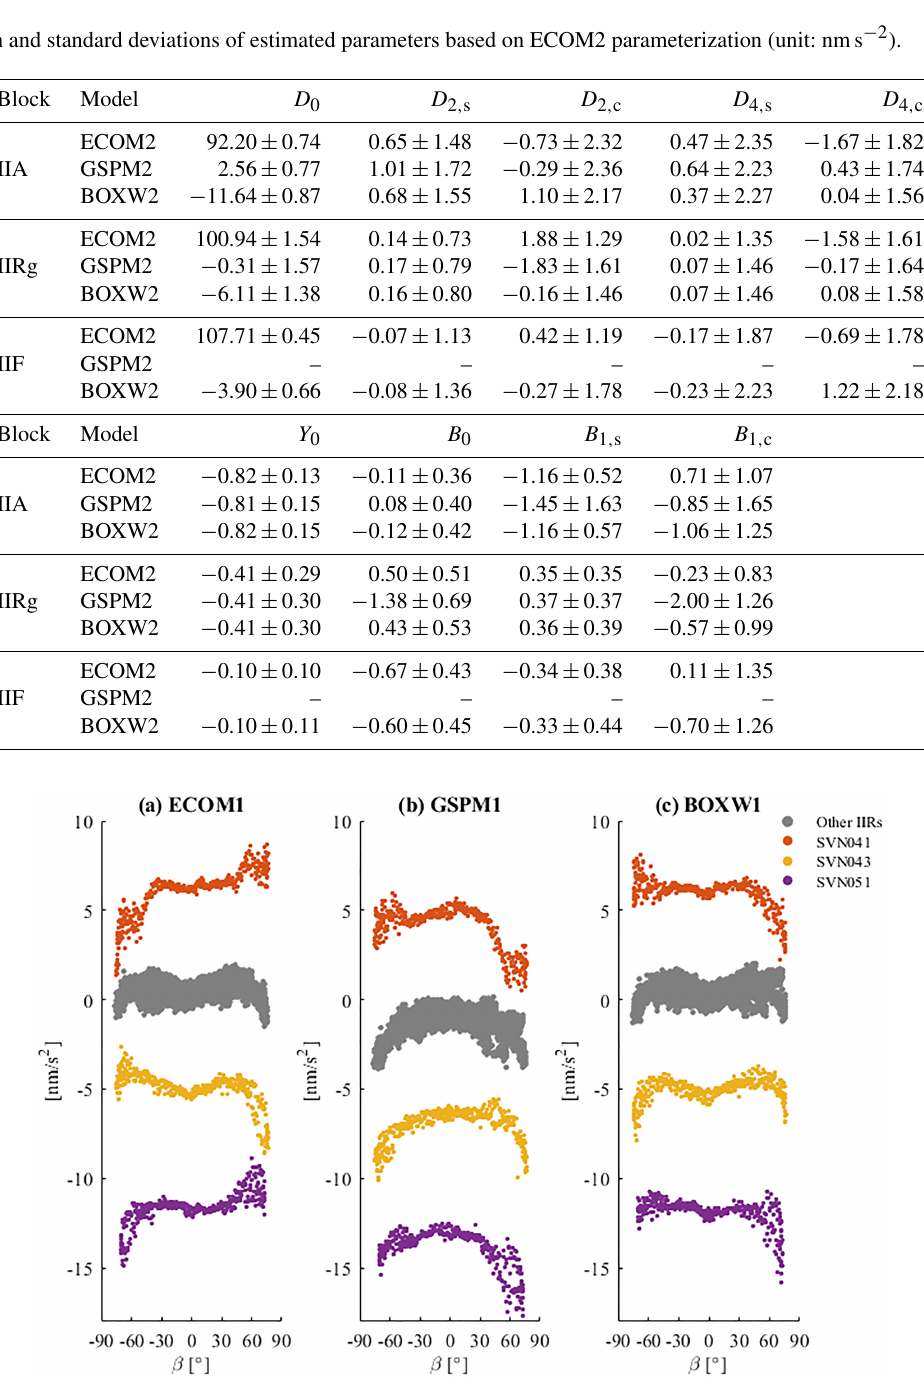
Figure 4. Estimated parameters B 0 based on ECOM1, GSPM1 and BOXW1 for Block IIR/IIR-M satellites. The parameters B 0 of SVN041, SVN043 and SVN051 are shifted 6, − 6 and -12nms − 2 w.r.t. original